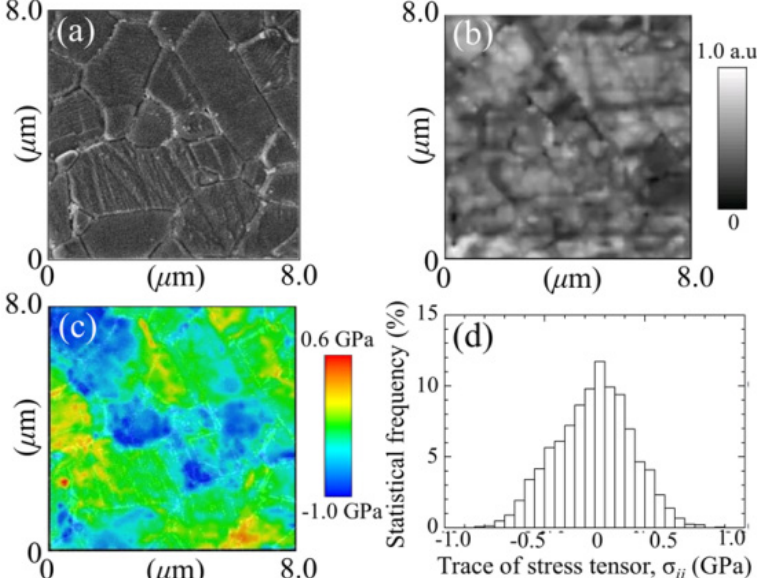
Figure 4. ( a ) A conventional scanning electron micrograph; ( b ) a CL intensity image; (F + /F band at 325 nm); and ( c ) a map of the trace of the residual stress tensor, shown for a randomly picked location on the surface of an early generation biomedical grade of polycrystalline alumina after long-term exposure in vivo (in a mildly worn area but away from the main wear zone); In ( d ), a histogram of the stress-trace magnitude is given, which represents the same data shown in the map ( c ). Stress magnitudes were deconvoluted in space, according to the procedure given in Refs. [75,82,83].